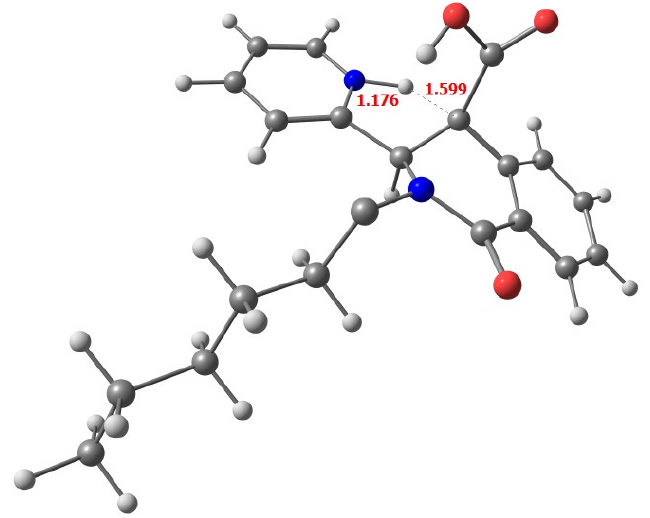
Figure 4. Optimized geometry at PCM/M06-2X/6-31 + G(d,p) level of theory (solvent dichloroethane) of transition state of cis - 6 epimerization.